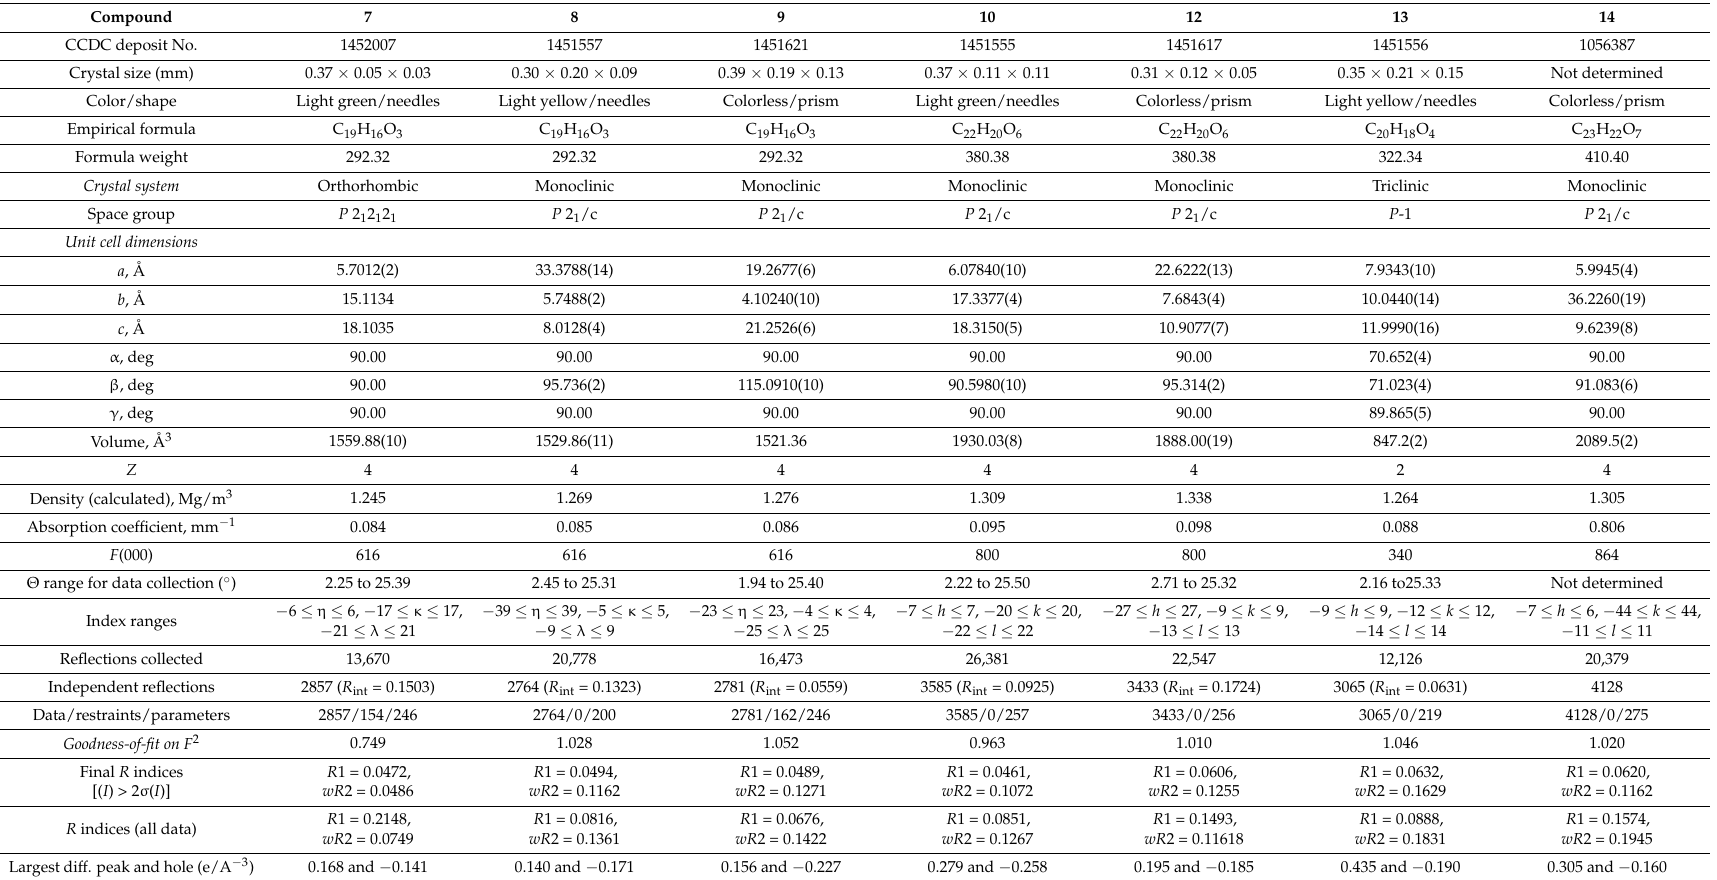
Table 1. Crystal data, collection parameters, and refinements for compounds 7 – 10 and 12 – 14